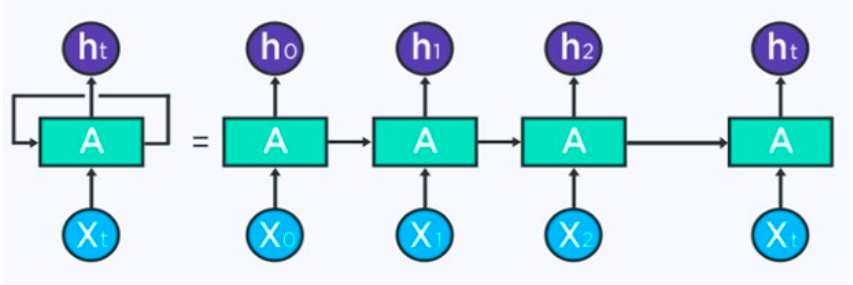
Figure 23. An unrolled version of an RNN